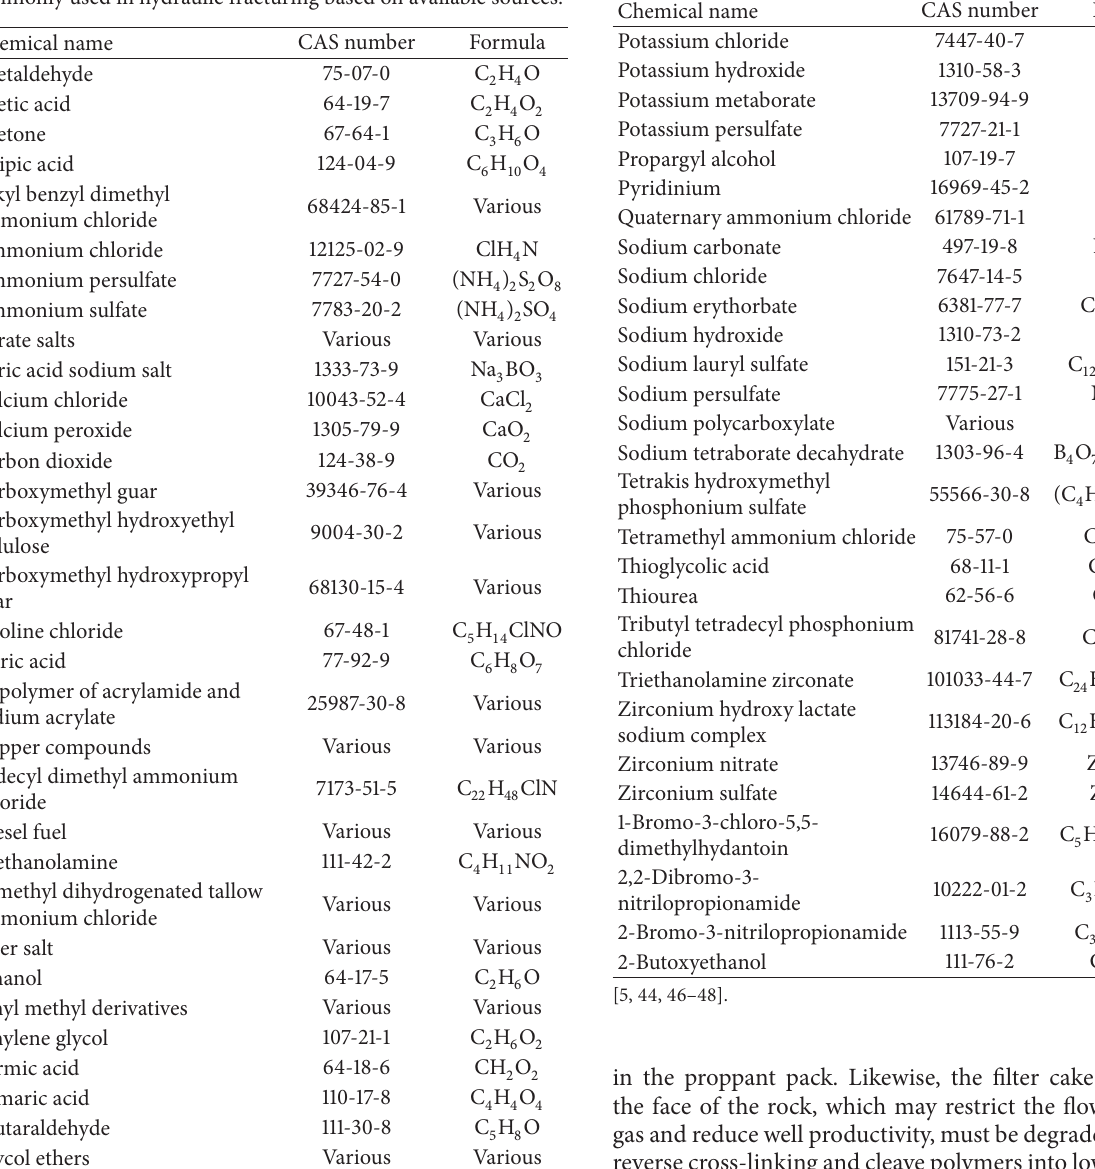
Table 2: Chemicals and chemical mixtures identified as being commonly used in hydraulic fracturing based on available